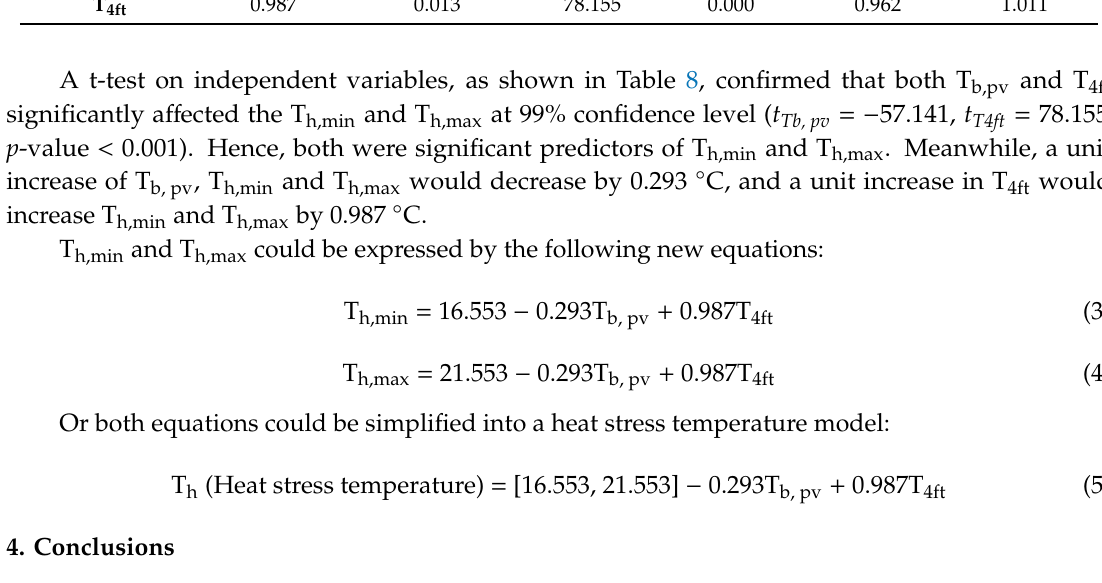
Table S1: Regression statistics of T h,min Model, Table S2: Analysis of variance (ANOVA) T h,min Model, Table S3: Individual t-test on independent variable T h,min Model, Table S4: Regression statistics T h,max Model, Table S5: Analysis of variance (ANOVA) T h,max Model, Table S6: Individual t-test on independent variable T h,max Model, Table S7: Variance inflation factor (VIF) for all independent variables, Figure S1: Boxplots for outlier detection. Figure S3: Normal QQ plot for residuals for normality; (a) Th,min model; (b) Th,max model, Figure S4: Residuals against fitted values plots for homoscedasticity; (a) Th,min model; (b) Th,max